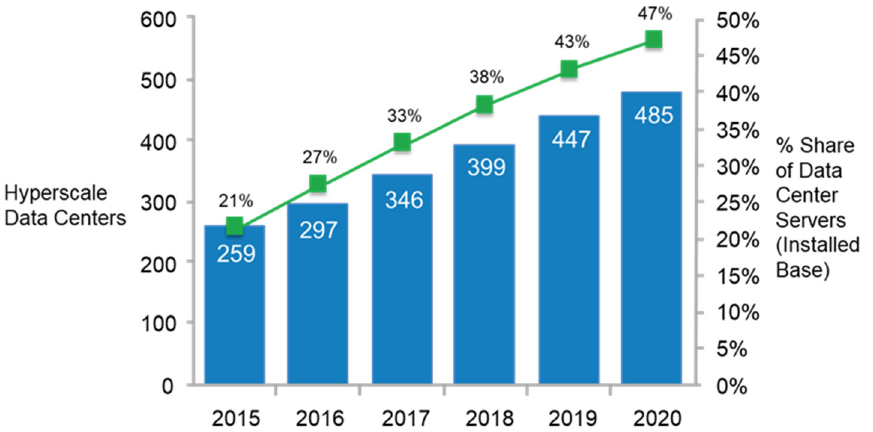
Figure 13. The number of data centers is accelerating (source: Cisco Global Cloud Index, 2015–2020, Synergy Research).